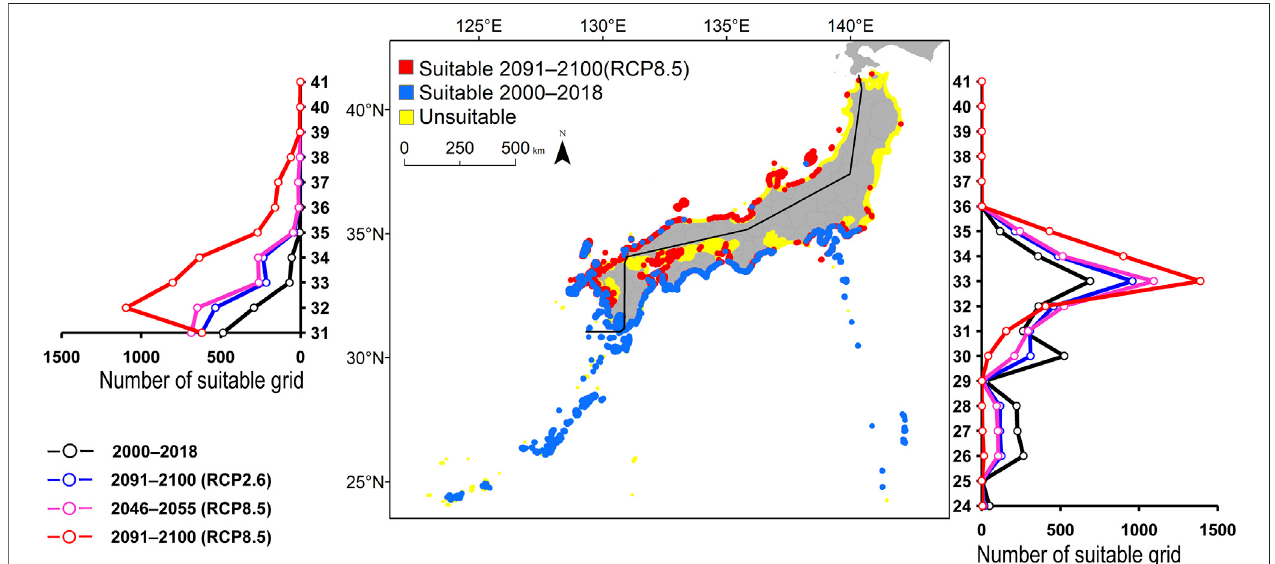
FIGURE 3 | Estimated distribution of Scarus ovifrons . See Figure 2 for the explanation.